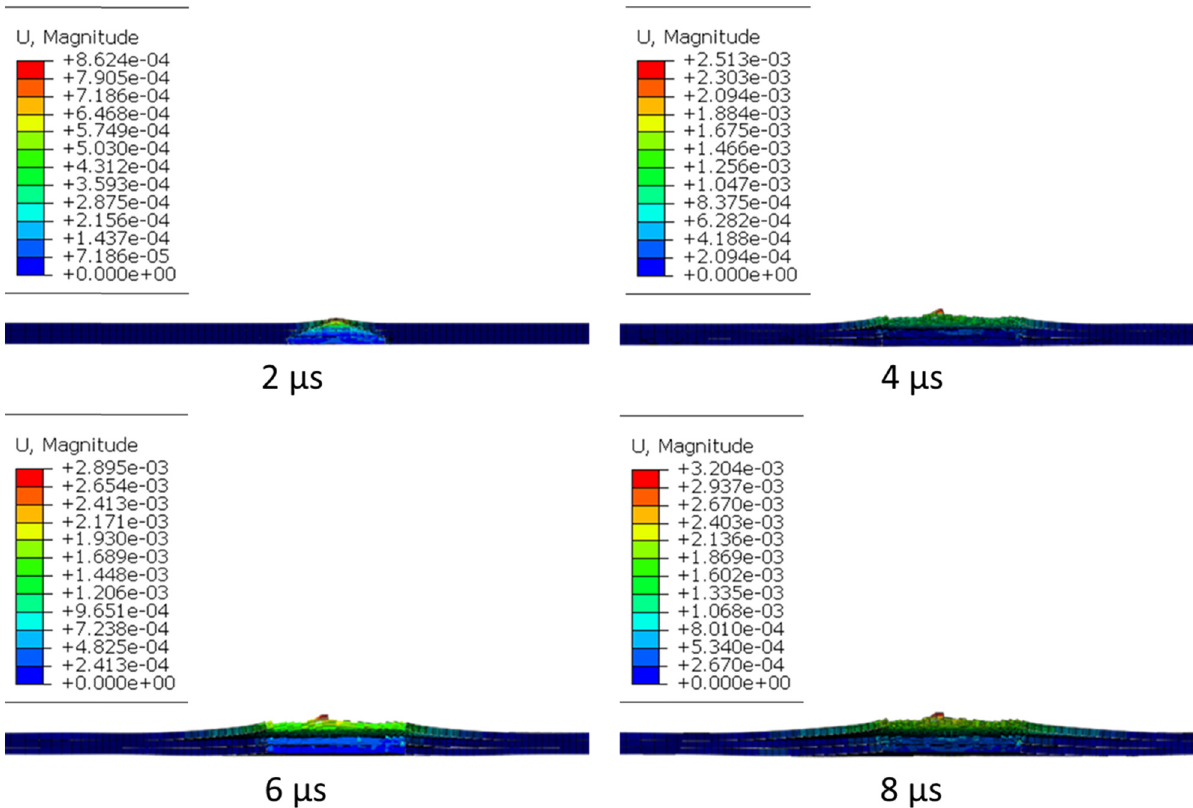
Figure 22: Displacement for model 7 against hemispherical